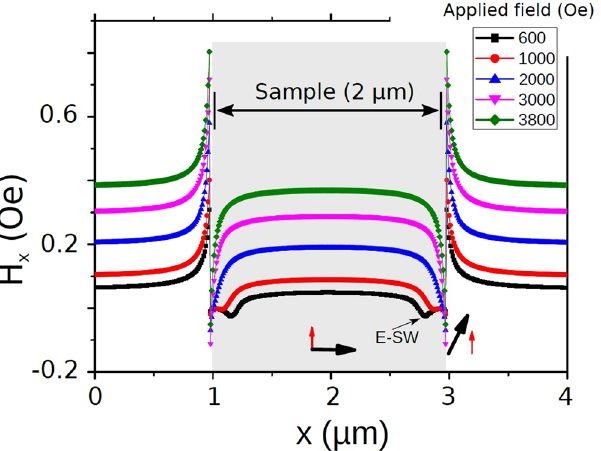
Figure 3. Simulated profiles of the H x component of the effective magnetic field in the direction parallel to the applied external field perpendicular to the edge of a square element of lateral size 2 μ m and thickness 30 nm (as shown in Fig. 2b). When a homogeneous RF pumping is perpendicular to the DC field, E-SWs could be excited only below some critical field when minimum of the effective field is formed close to the edge. For larger DC fields the excitation of the E-SWs is suppressed because the torque is applied mainly inside the strip (at the bottom, the black arrow represents the DC effective field direction, and the red arrow the high frequency field direction). The cross section of the field represented in this graph is taken as indicated by the dashed blue line in Fig.